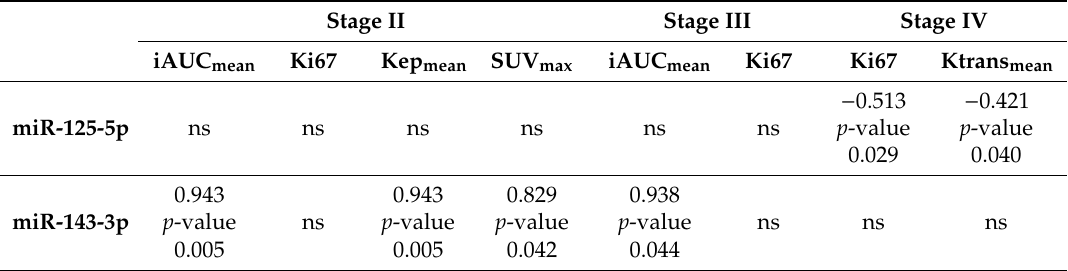
ns indicates non-significant results. iAUC mean : area under the concentration curve; SUV max : maximum standardized uptake value; Kep mean : mean reverse e ffl ux volume transfer constant; Ktrans mean : mean forward volume